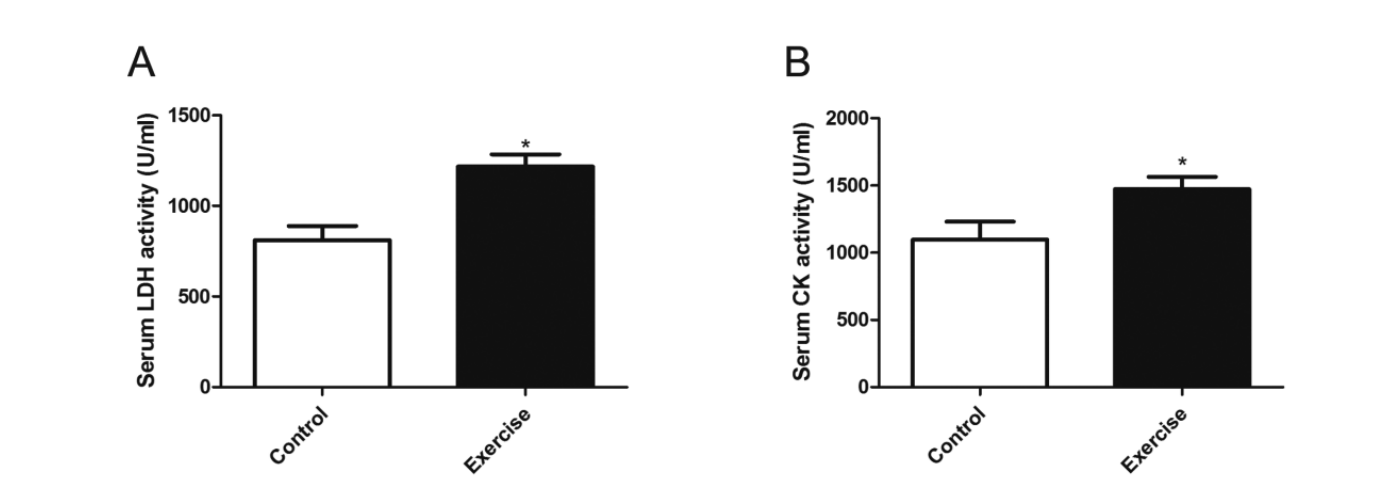
Figure 4. (A) Mean serum lactate dehydrogenase (LDH) activities after a single exhaustive resistance exercise session. (B) Mean serum creatine kinase (CK) activities after a single exhaustive exercise session. Each bar represents the mean ± SEM of rats. * different from Control group; P <